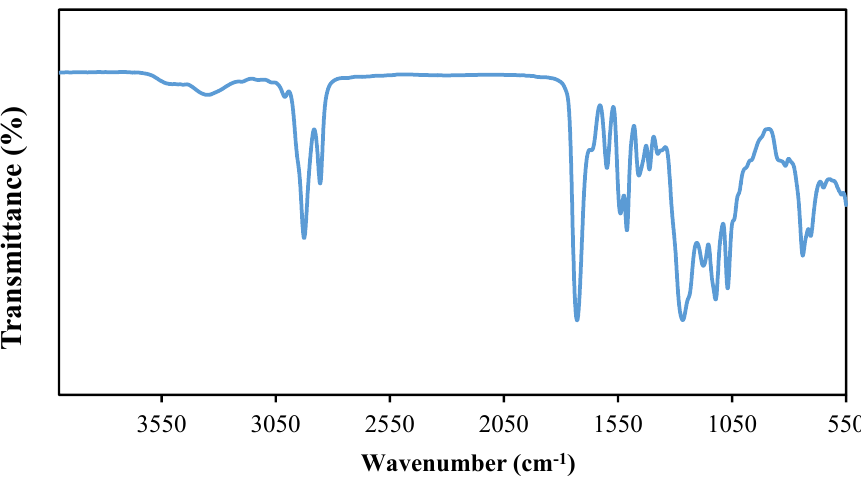
Figure 1. FTIR spectrum of castor oil-based